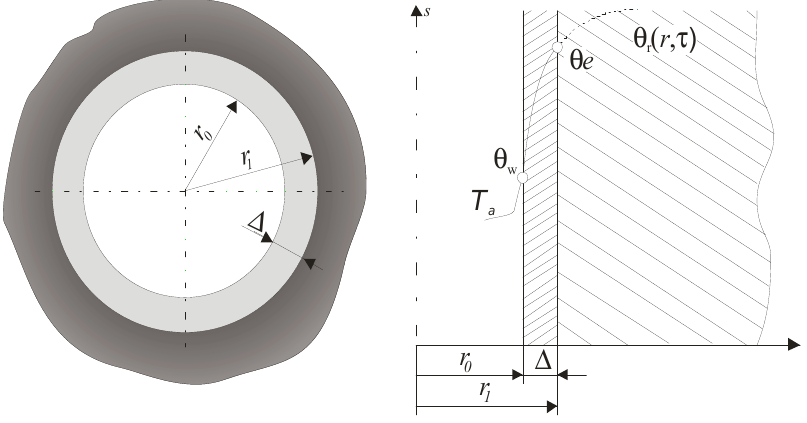
Figure 6. Schematic diagram of the heat flow model through the thermal insulation layer of a mining excavation.